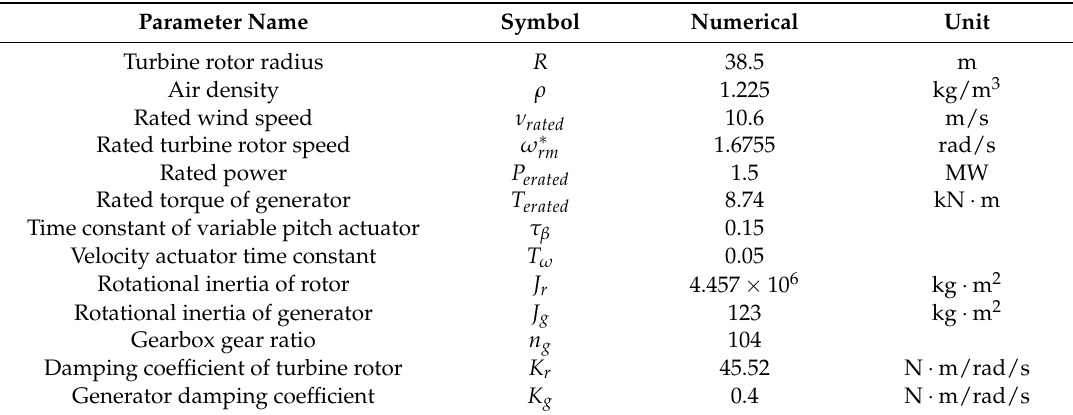
Table 1. Related parameters of variable speed control system of wind turbines.